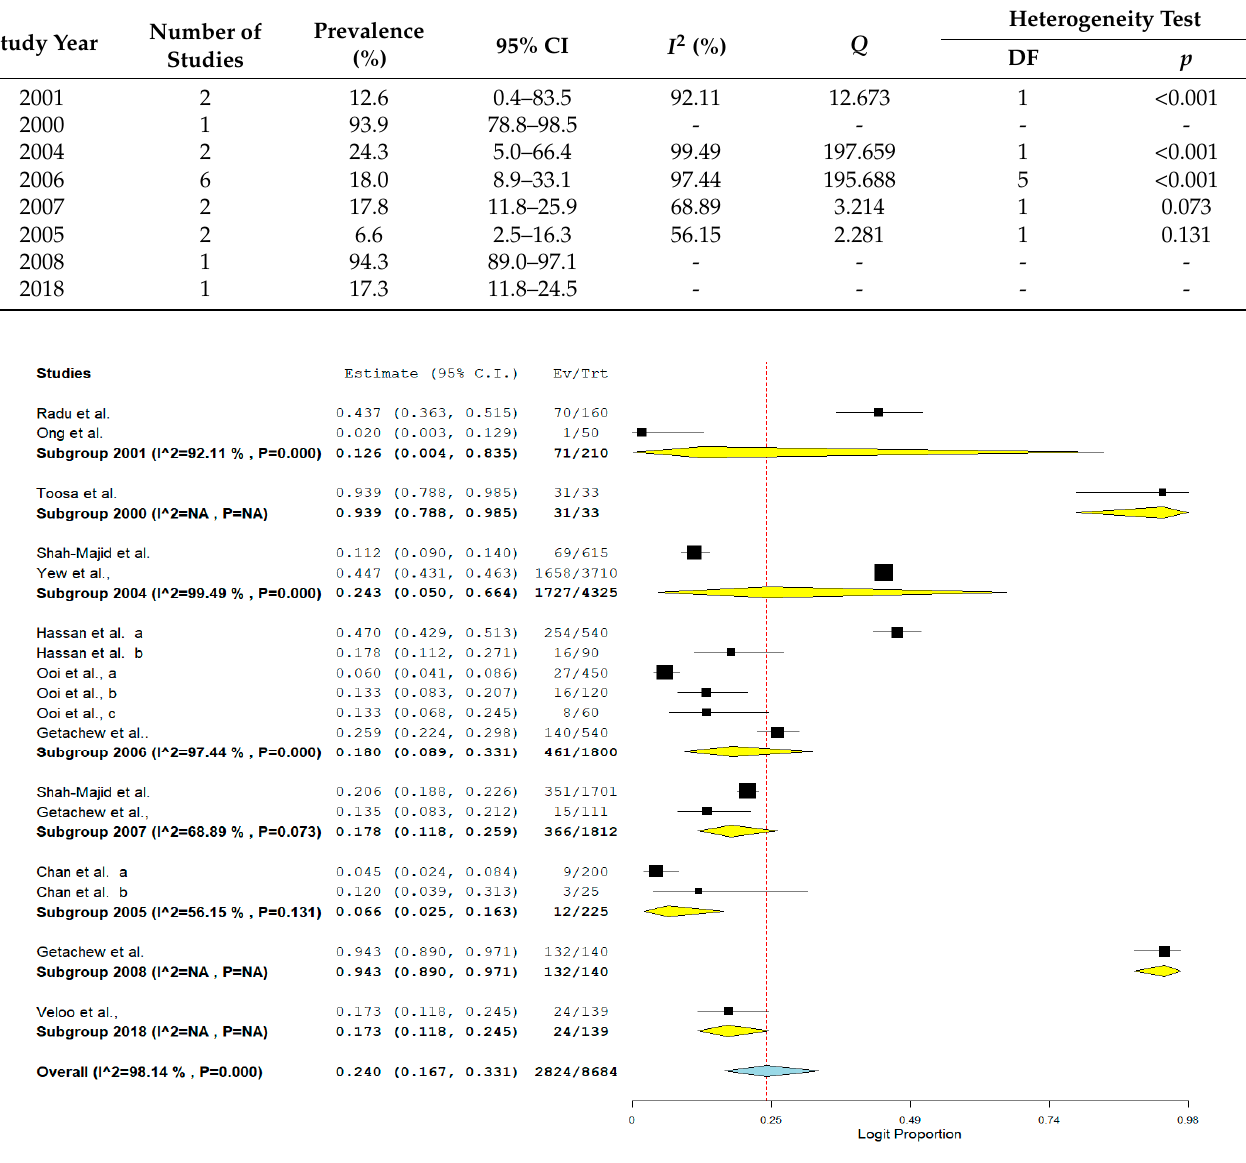
Figure 6. Forest plot showing the subgroup meta-analysis by study year of VRE in poultry in Malaysia.